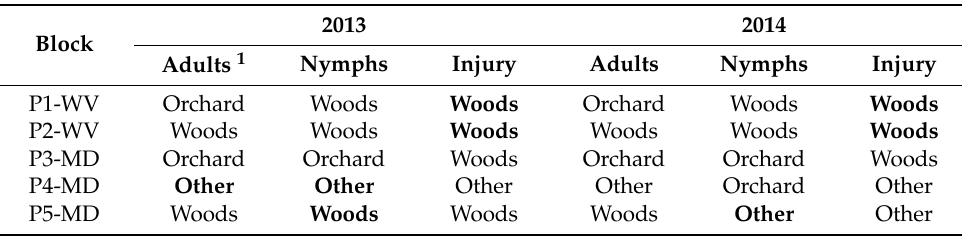
Table 7. Qualitative comparisons of H. halys adult and nymph captures and fruit injury at harvest by orchard border habitat in peach blocks in the Mid-Atlantic, USA, in 2013 and